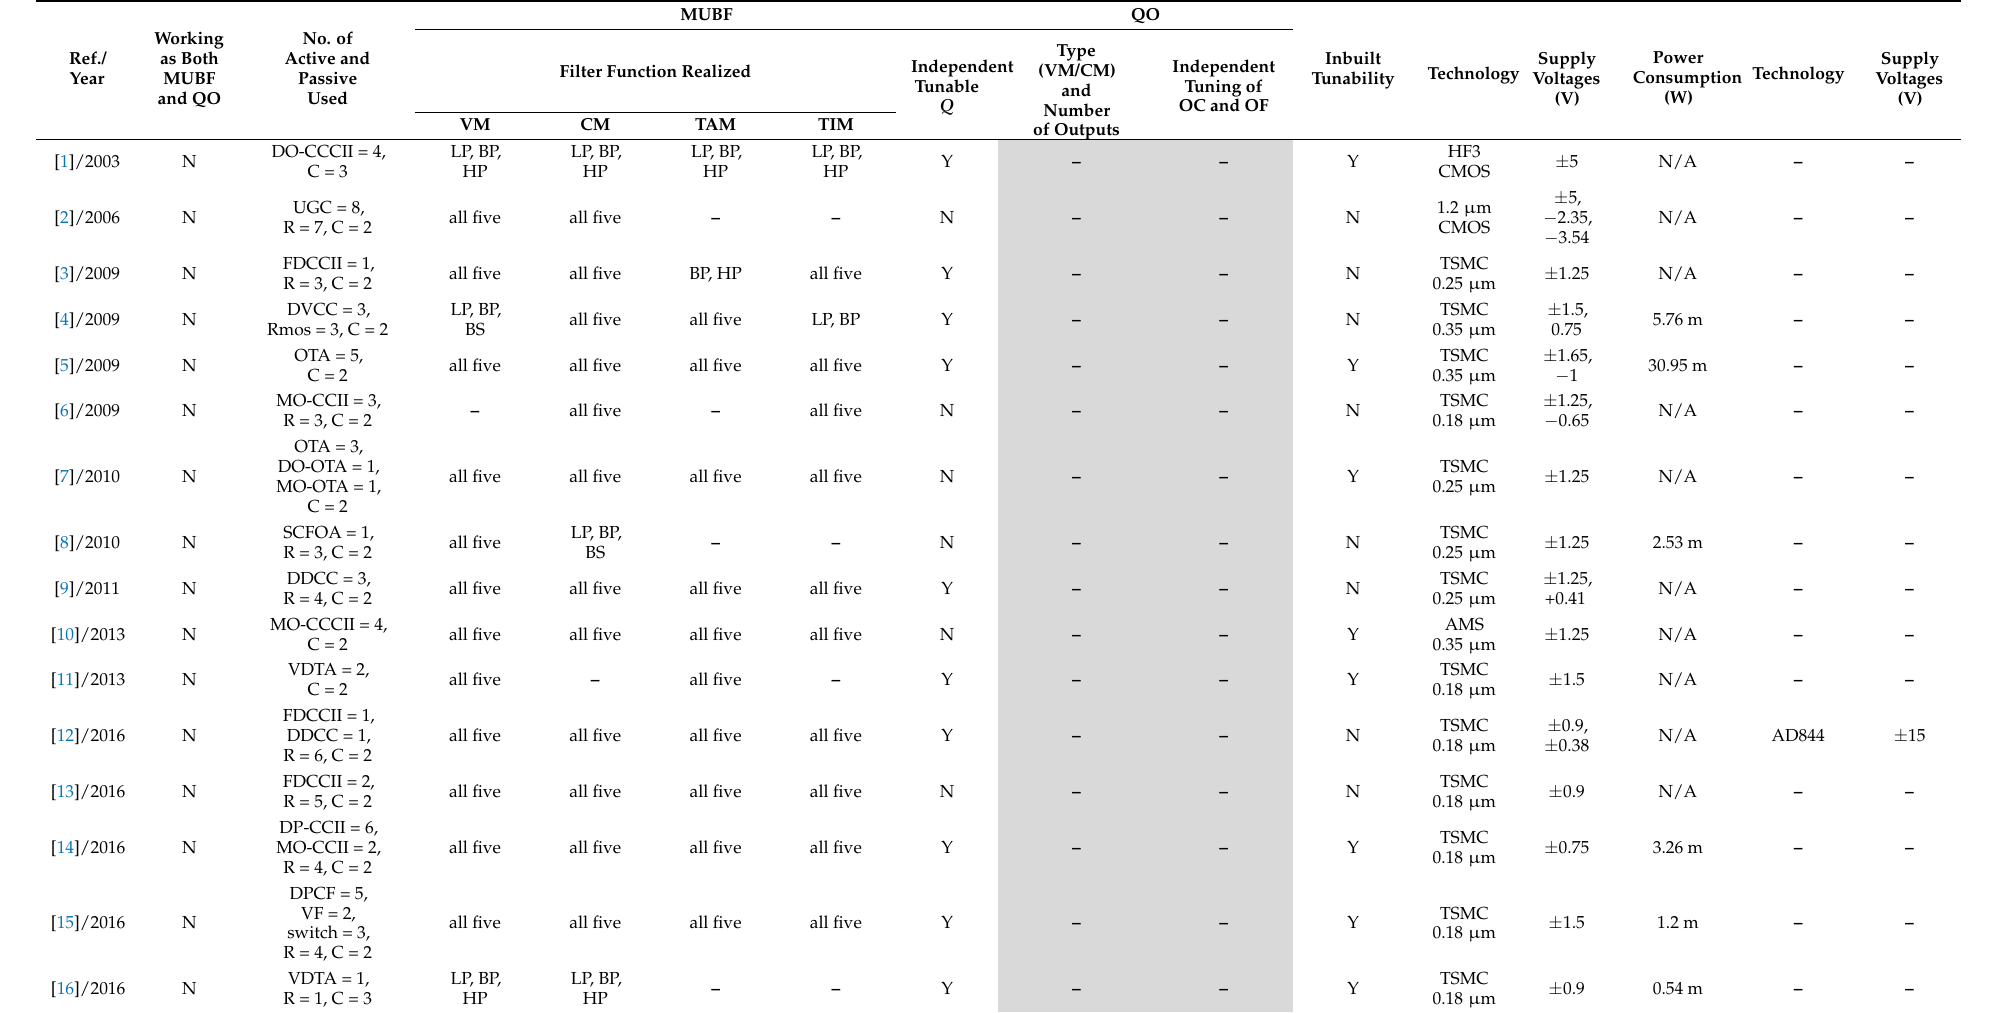
Table 1. Comparison of the proposed circuit to previous related MUBF and QO circuits in